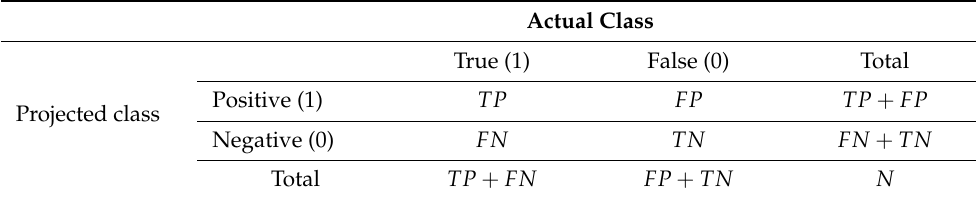
Table 2. Confusion matrix